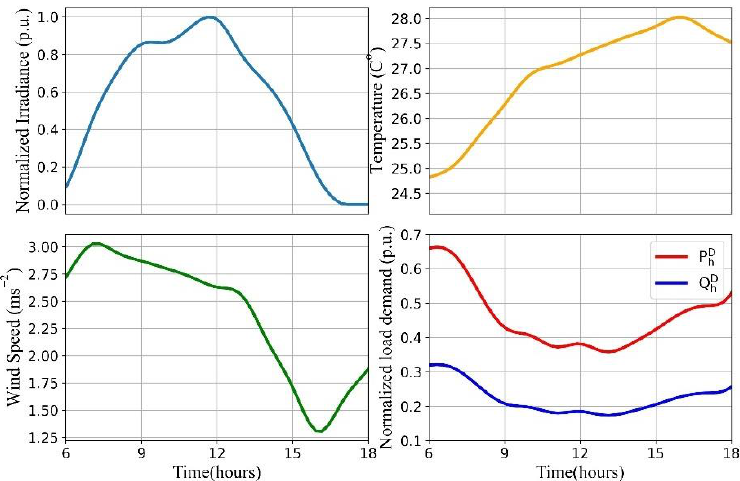
Figure 7. Variation of the irradiance, temperature, wind speed, and the load demand during the assessment period